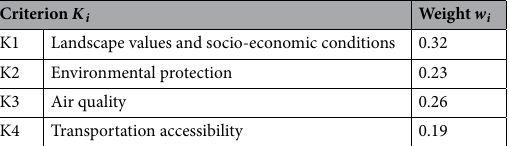
Table 2. Criterion weights for RPI calculation (Source: own